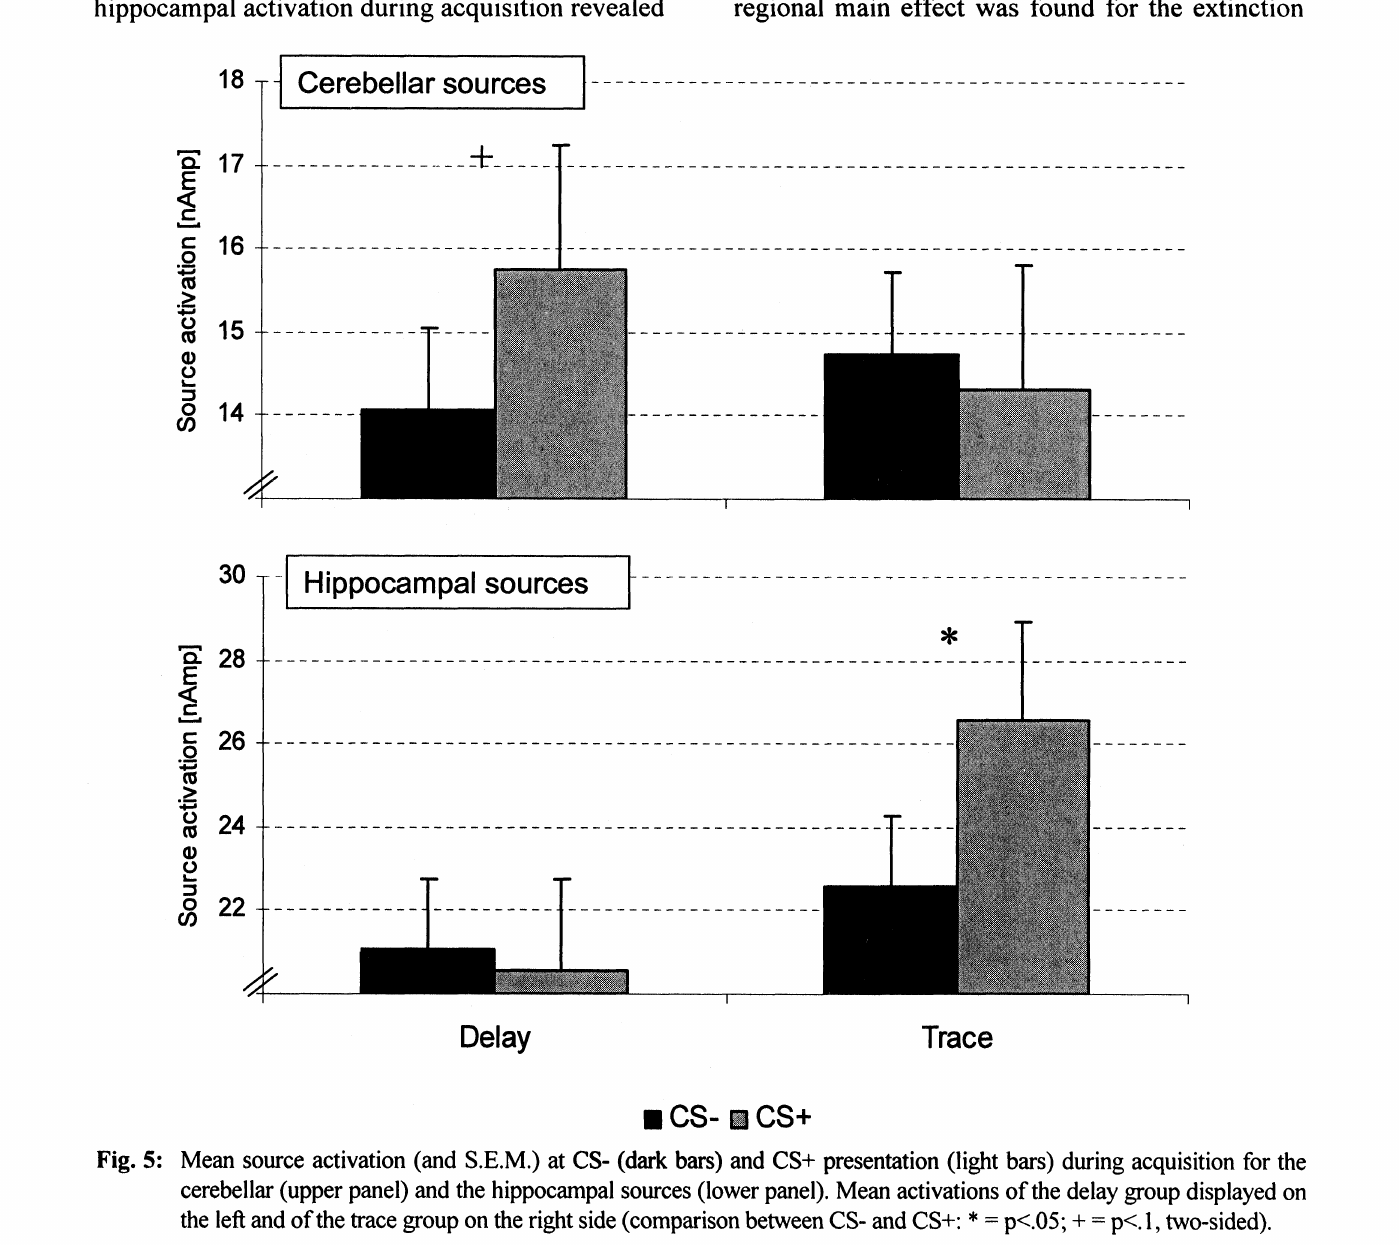
Fig. 5: Mean source activation (and S.E.M.) at CS- (dark bars) and CS+ presentation (light bars) during acquisition for the cerebellar (upper panel) and the hippocampal sources (lower panel). Mean activations ofthe delay group displayed on the left and of the trace group on the right side (comparison between CS- and CS+: * p<.05; + p<.l,